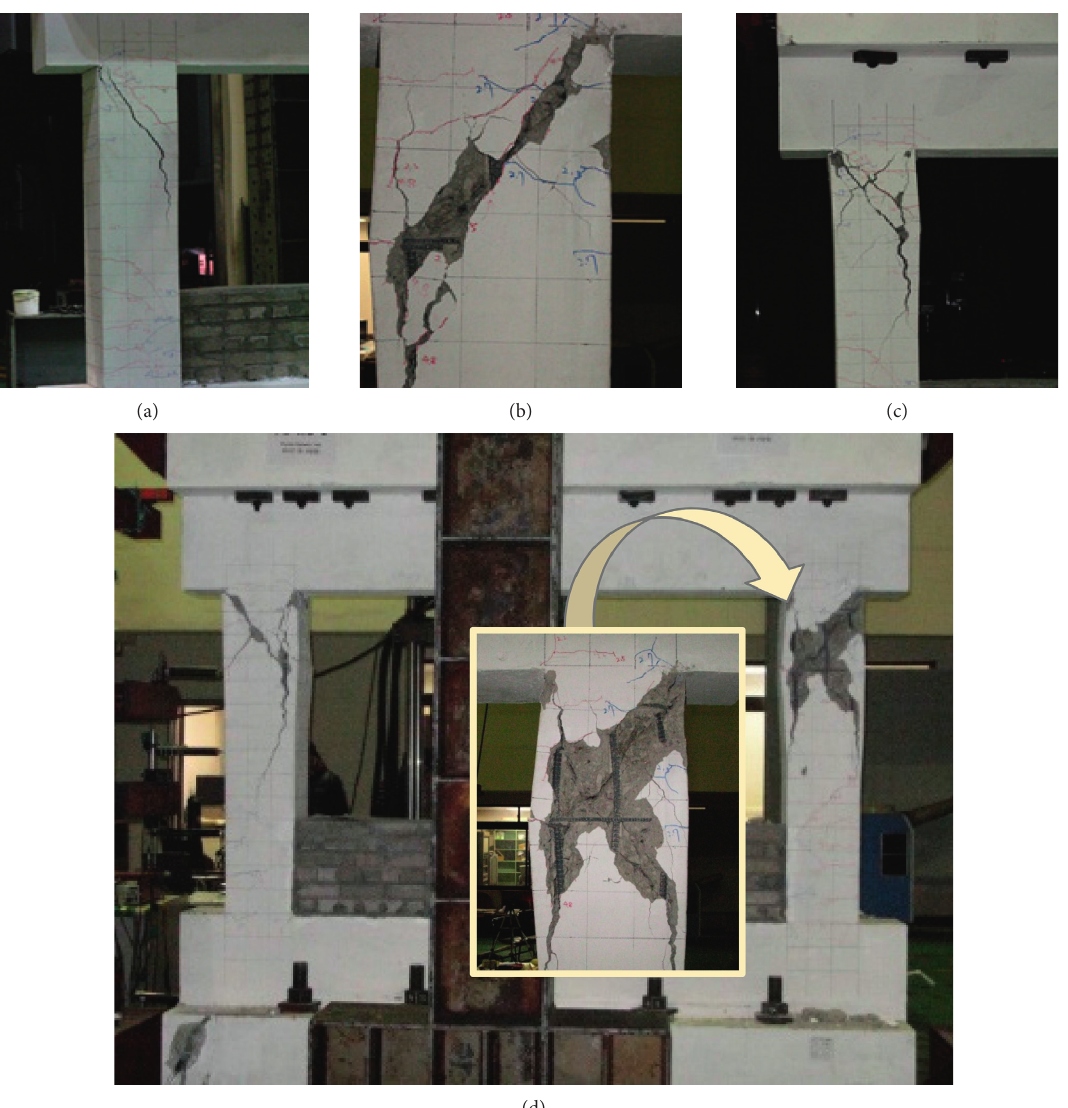
Figure 21: Cracks appeared in the PD-F specimen during pseudodynamic testing at 300gal, after (a) 1.52s with lateral displacement of 10mm and force of –204 kN, (b) 2.18 s with lateral displacement of 24.9mm and force of –268kN, (c) 5.4 s with lateral displacement of 28.9mm and force of 80kN, and (d) during the final stage (7s).